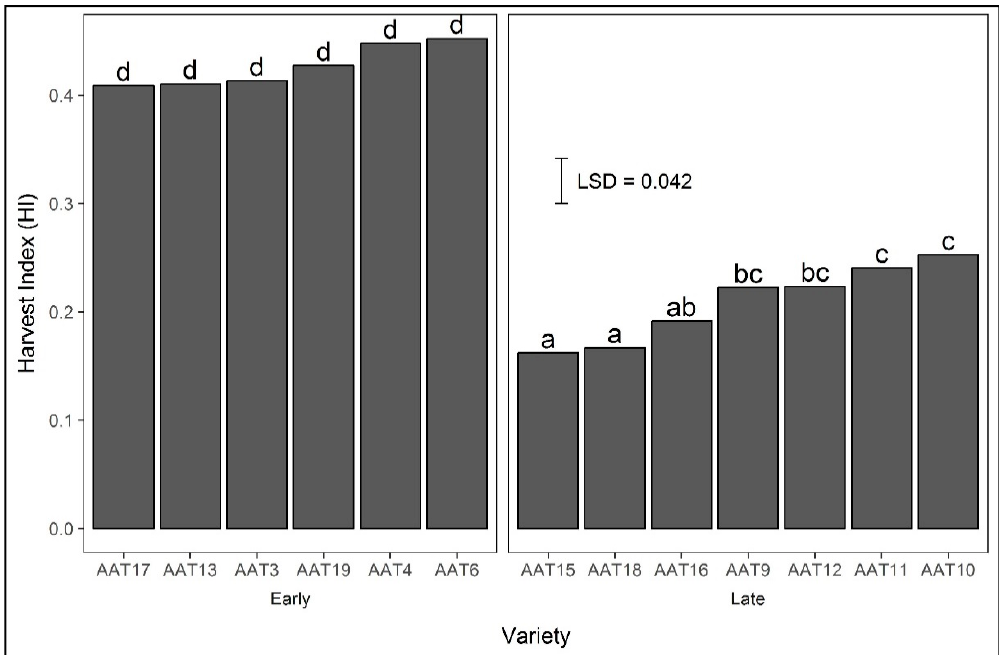
Figure 4. Means of varietal harvest index averaged across years 2014 and 2015. Bars followed by different letters differ significantly at p = 0.05.